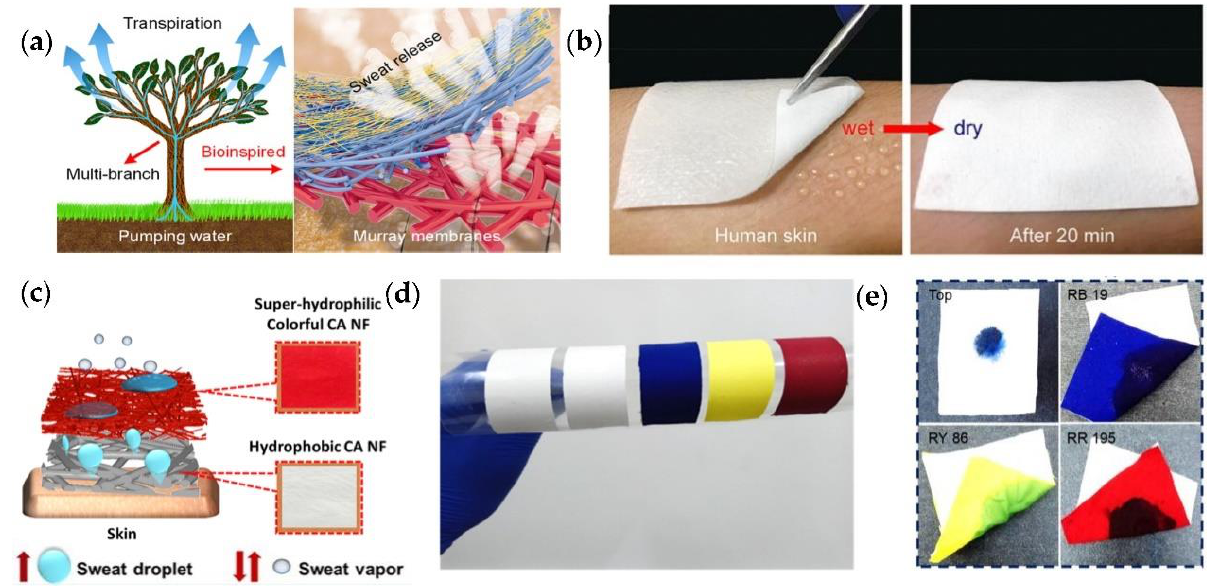
Figure 8. ( a ) The antigravity directional water transport and schematic demonstration of the sweat- release process of biomimetic porous Murray membrane. ( b ) Optical images of the quick-dry performance of the porous Murray membrane [66] (Copyright 2019, American Chemical Society). ( c ) Schematic illustrating the sweat-release process of the colorful DWT membrane. ( d ) Optical images of dyed nanofibers after dyeing. ( e ) Optical images of the water-penetration phenomenon from both sides of the composite membrane [65] (Copyright 2018, American Chemical Society).